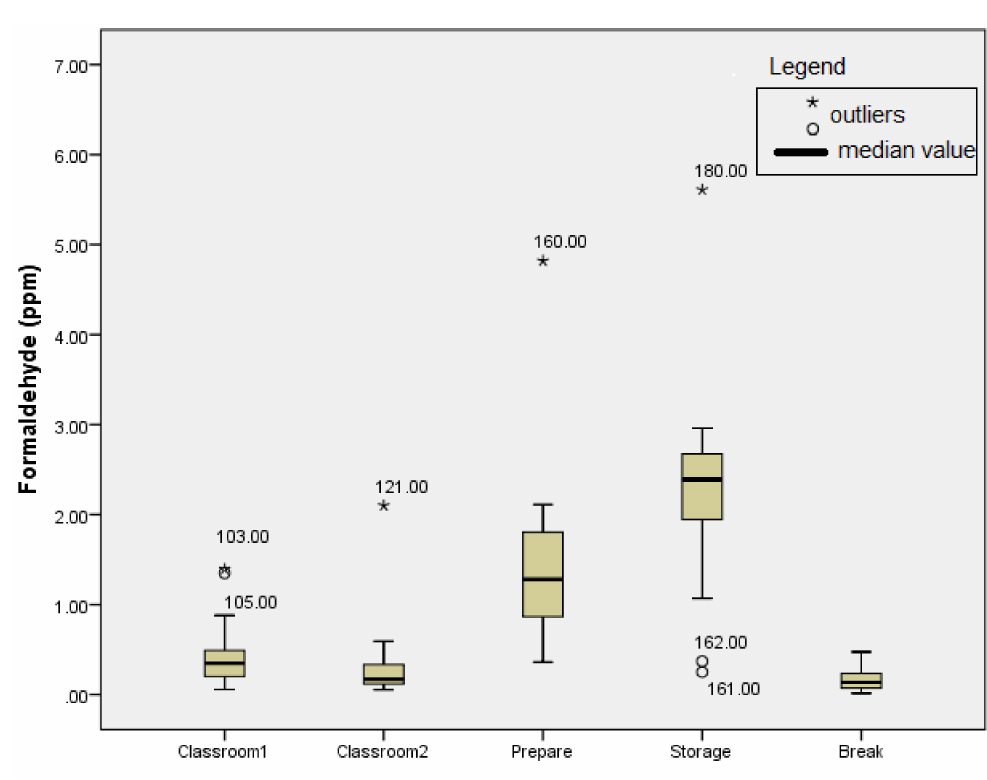
Figure 2. The results of the second sampling